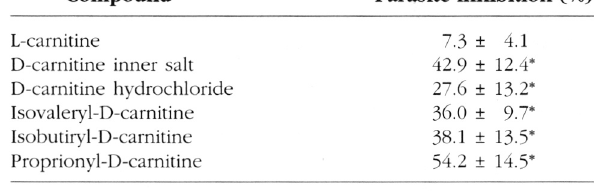
Table I. — Percent parasite inhibition in rats infected with T. lew isi and treated with L-carnitine or different formulations and derivatives of D-carnitine at the dose of 300 mg/kg/day for five days.